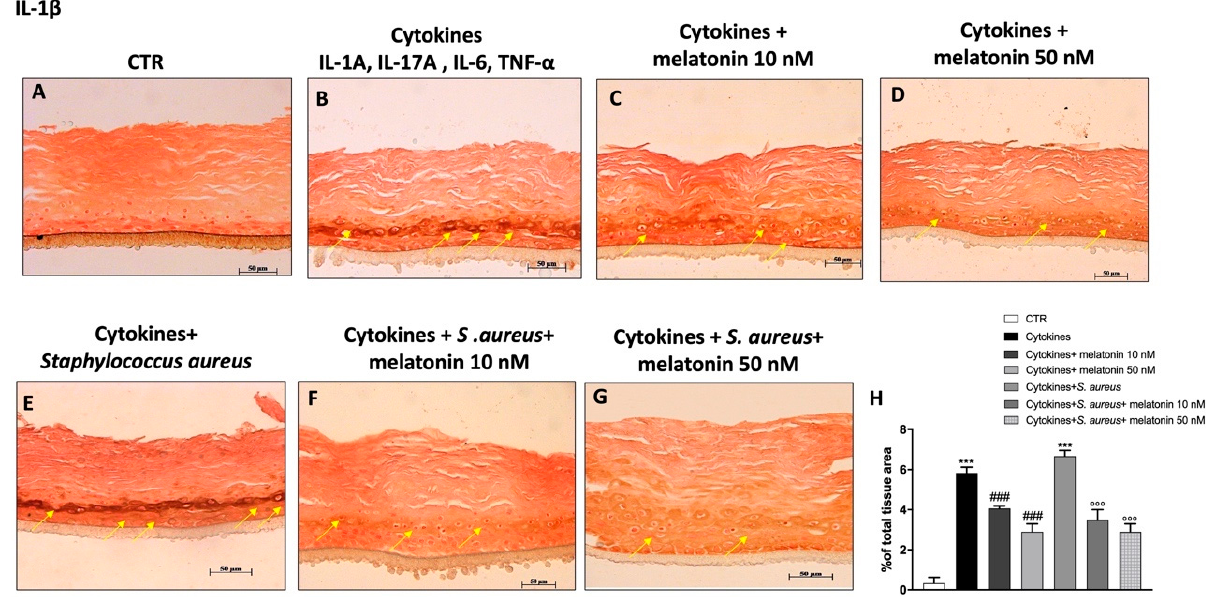
Figure 7. Effect of melatonin on IL-1 β expression. Immunohistochemical staining revealed that the cytokines and S. aureus group were characterized by an increase of IL-1 β expression compared to the control ( A , B , E ), while melatonin treatment at 10 nM and 50 nM significantly reduced its expression ( C , D , F , G ). The yellow arrows indicate the positive staining. Data are representative of at least three independent experiments. ( H ) *** p < 0.001 vs. CTR; ### p < 0.001 vs. cytokines group; ◦◦◦ p < 0.001 vs. cytokines + S. aureus group.